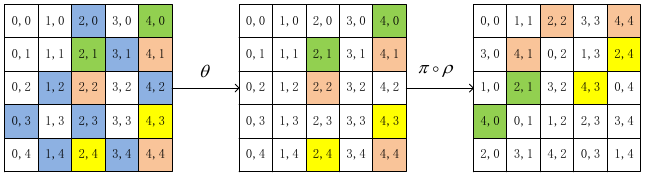
Figure 22: Attack on 6-round Ketje Sr v2 with 128-bit